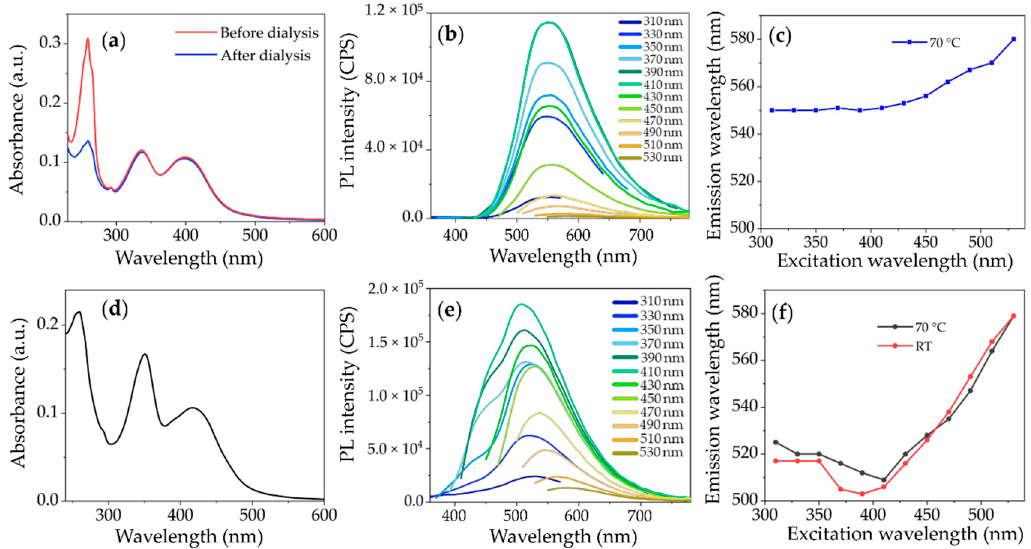
Figure 4. ( a,d ) UV-Vis absorption spectra of representative samples synthesized at 70 °C of W-CDs before and after purification ( a ) and O-CDs (the spectrum does not change after purification) ( d ); ( b,e ) PL spectra recorded with varying the λ exc of the respective aqueous and organic phases after separation; ( c,f ) trend of the spectra position of the emission peak as a function of the λ exc of W-CDs and O-CDs, respectively. In ( f ) the data at RT are also reported for comparison.